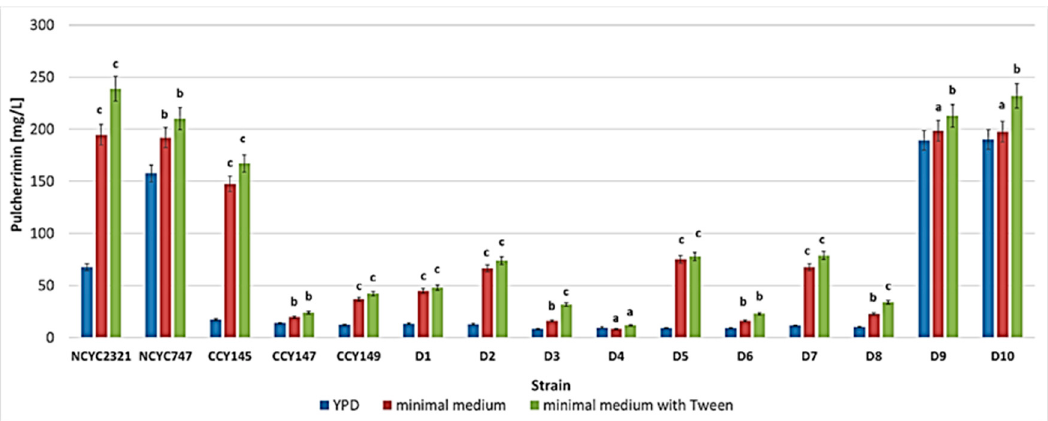
( b ) Figure 1. Pulcherrimin spectra: ( a ) spectrophotometry with the maximum absorption at three characteristic wavelengths: 240, 280 and 410 nm; ( b ) 1 H NMR spectroscopy with the characteristic signals of CH 3 , CH 2 and CH, belonging to isobutyl groups; the large solvent peak is typical for analyses carried out for solutions in D 2 O. 3.2. Pulcherrimin Formation The tested Metschnikowia strains were characterized by various levels of pulcherrimin formation.